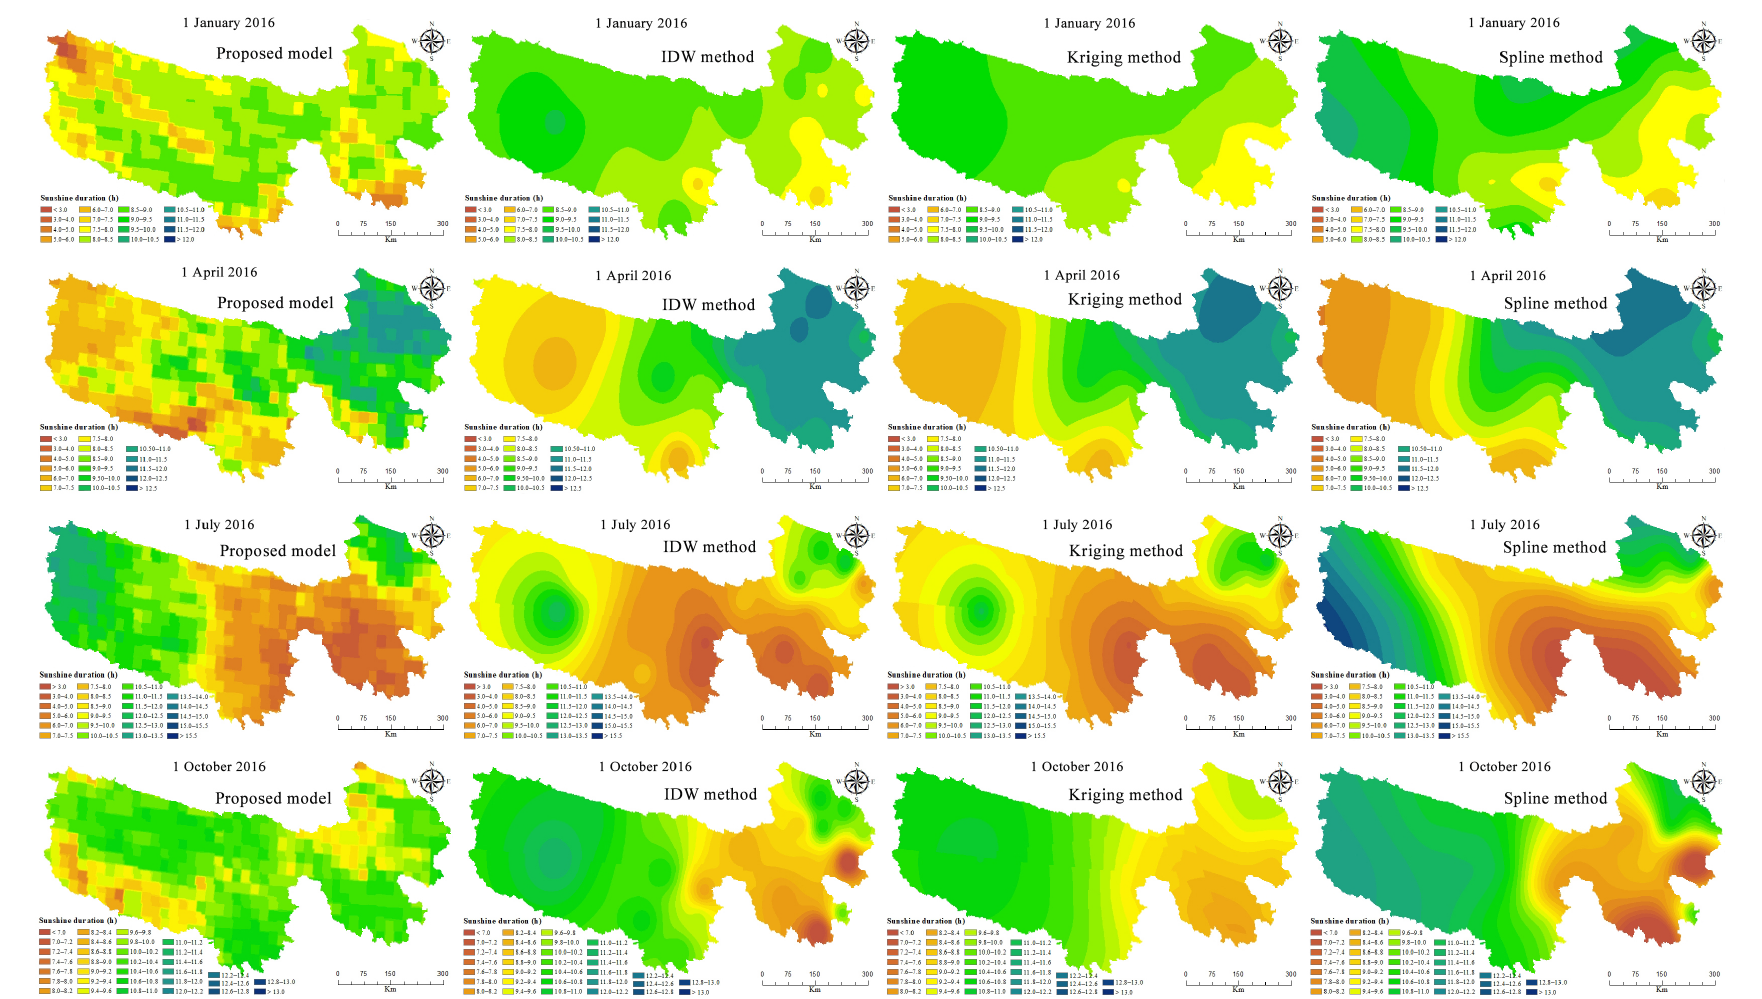
Figure 7. Spatial distribution of sunshine duration estimated by the proposed model (first column), Inverse distance weighted interpolation (IDW) method (second column), Kriging method (third column), and spline method (fourth column) in di ff erent seasons of 2016 over the Three-River Headwaters